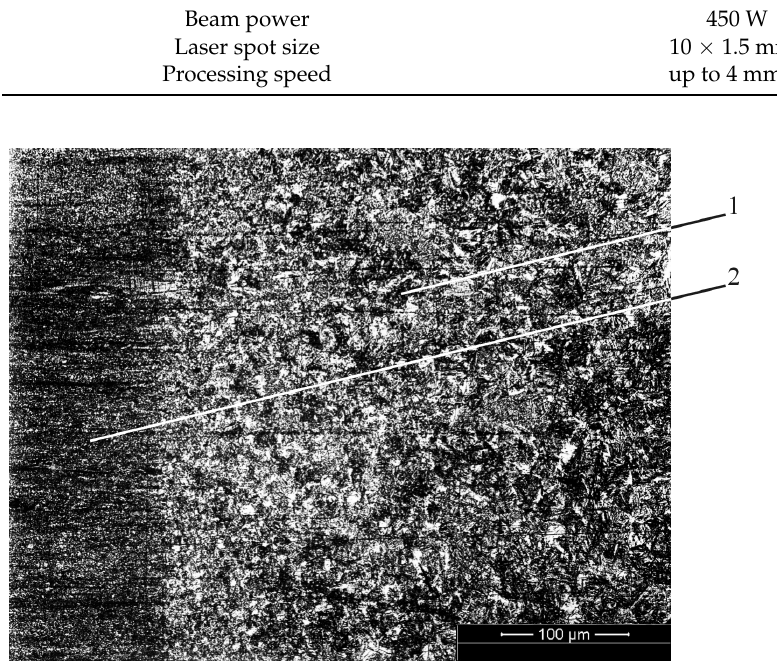
Figure 6. Ti-2Al-1.5Mn rolled sheet titanium alloy structure after laser annealing: 1—annealing zone; 2—initial structure [101]. 2—initial structure